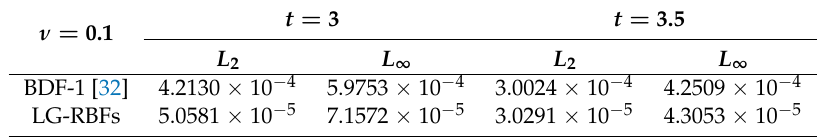
Table 5. Comparison of error norms for different values of final times with M = 10 and ∆ t = 0.01. t = 3 t = ν = 0.1